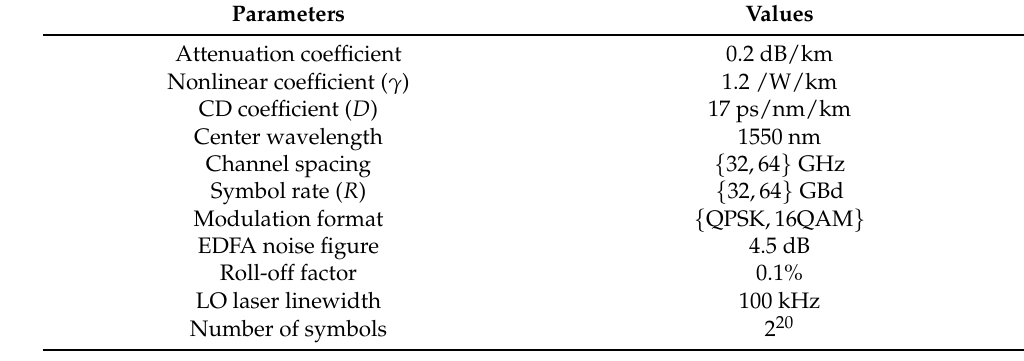
Table 1. System simulation setup parameters.